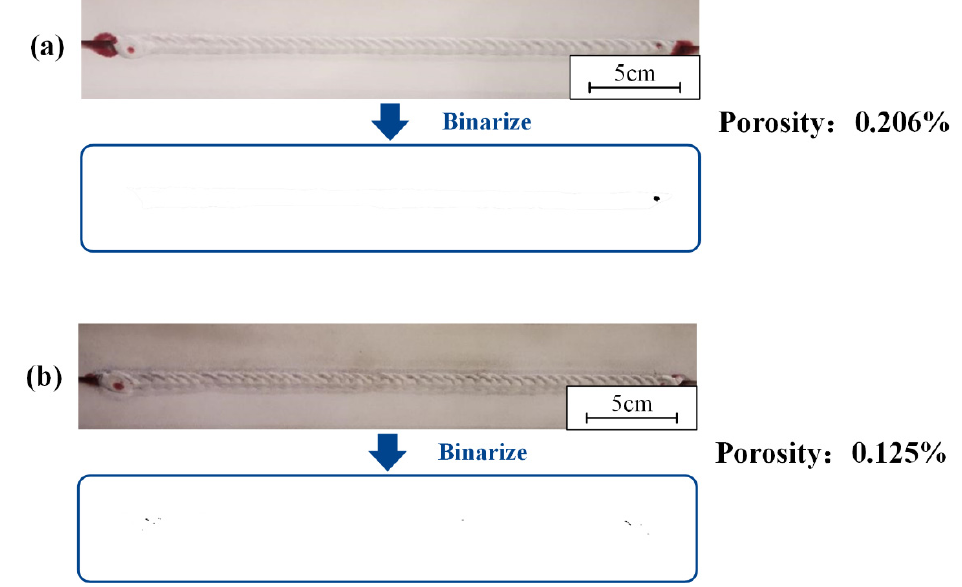
Figure 12. The result of the permeation testing and the porosity: ( a ) the lap surface was not cleaned; ( b ) the lap surface was cleaned.